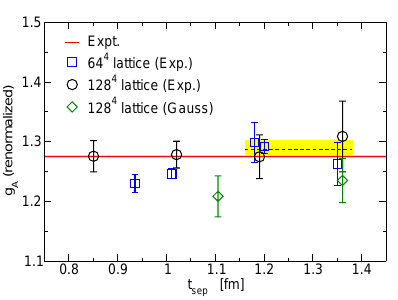
Figure 1: t sep dependence of the renormalized values of g A . The horizontal axis denotes the source-sink separation t sep in physical unit. Square symbols for the L = 64 calculations have been slightly shifted in horizontal direction if they need to avoid overlap. The solid line denotes the experimental value, while the dotted line shows the average value, and shaded band displays the fit range and one standard deviation. This figure is reprinted from Ref. [21].